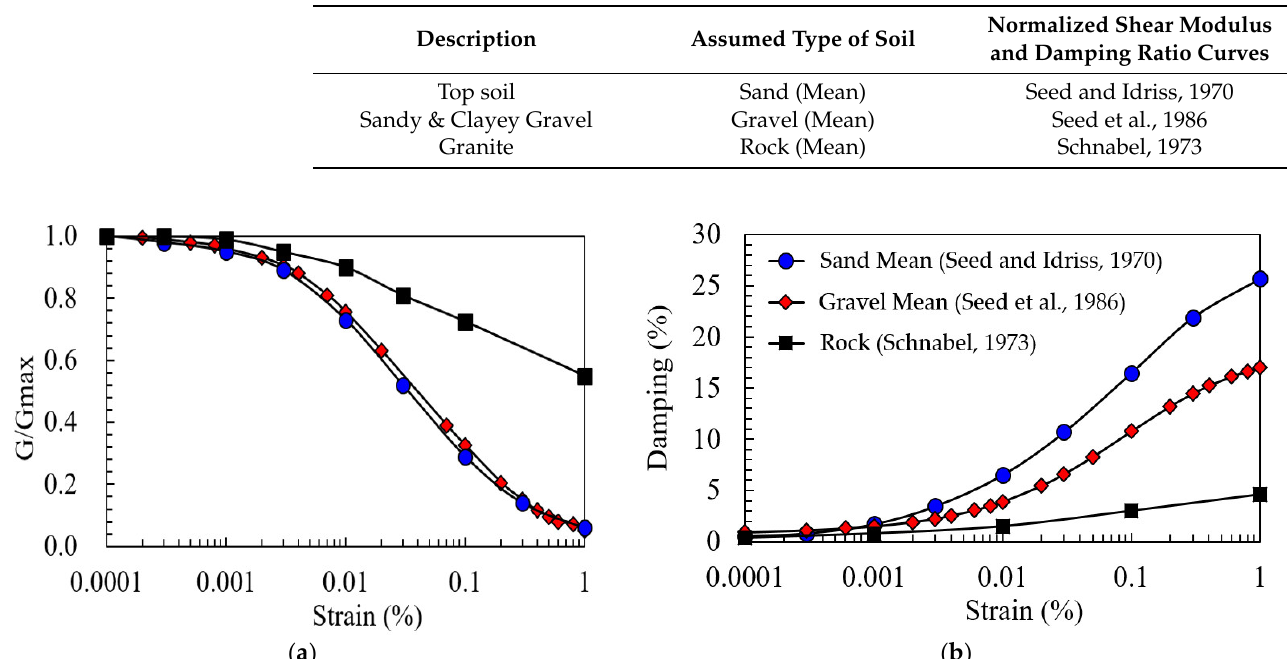
Table 2. Description, normalized shear modulus and damping ratio curves.